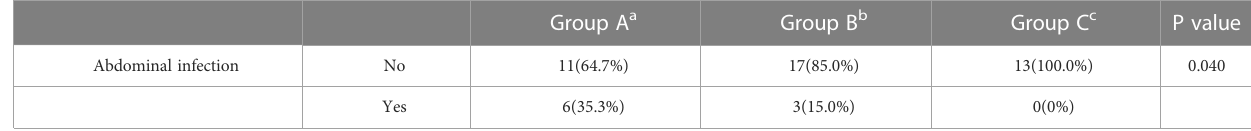
TABLE 4 Abdominal infection of intracorporal anastomosis in different